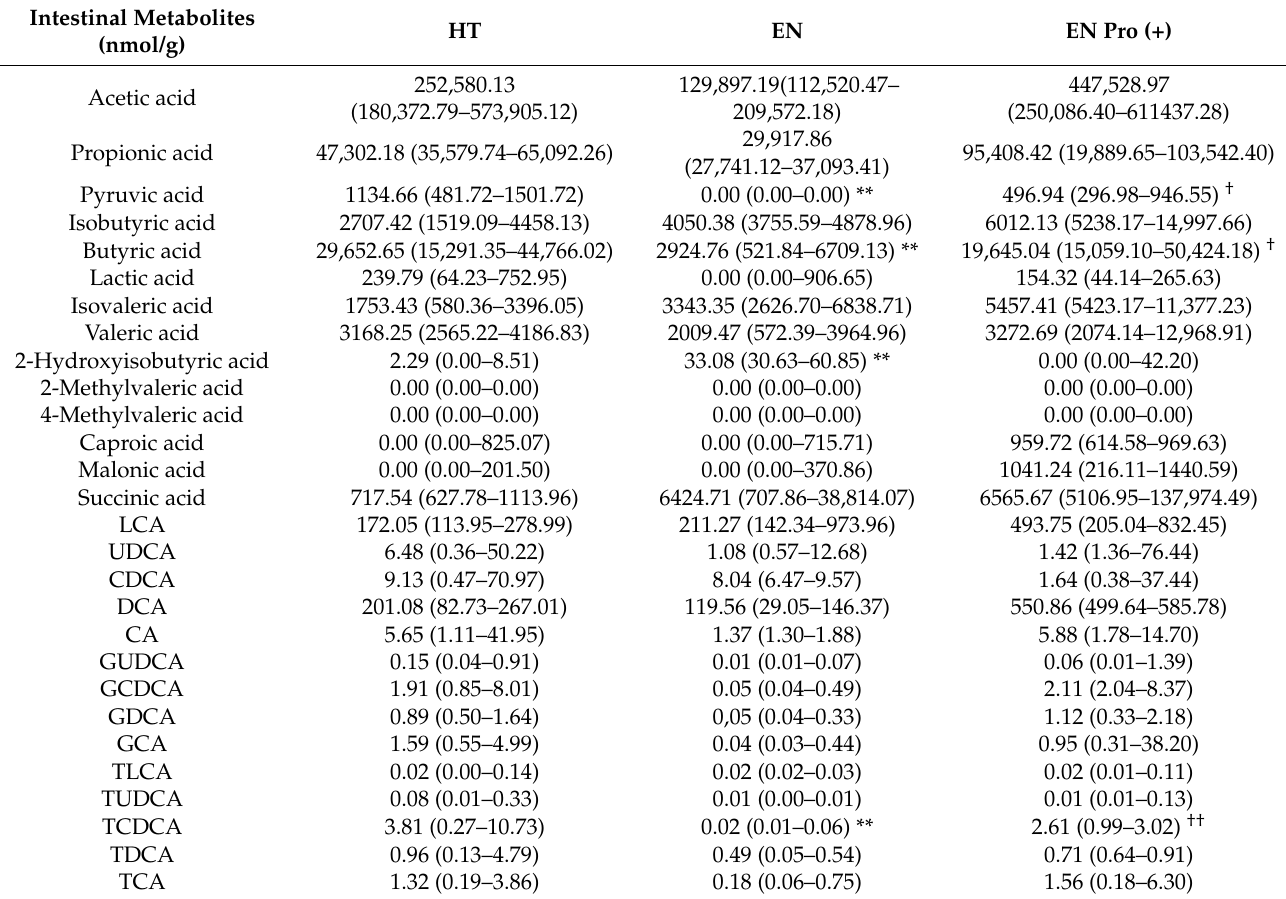
Table 2. Metabolomic analysis of intestinal metabolites